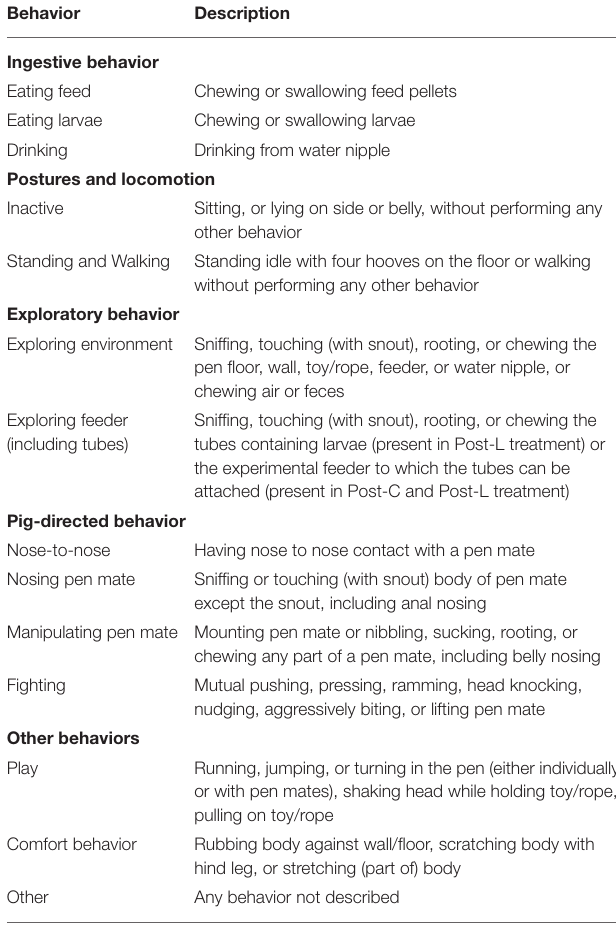
TABLE 2 | Ethogram of behavior observed in the home pen